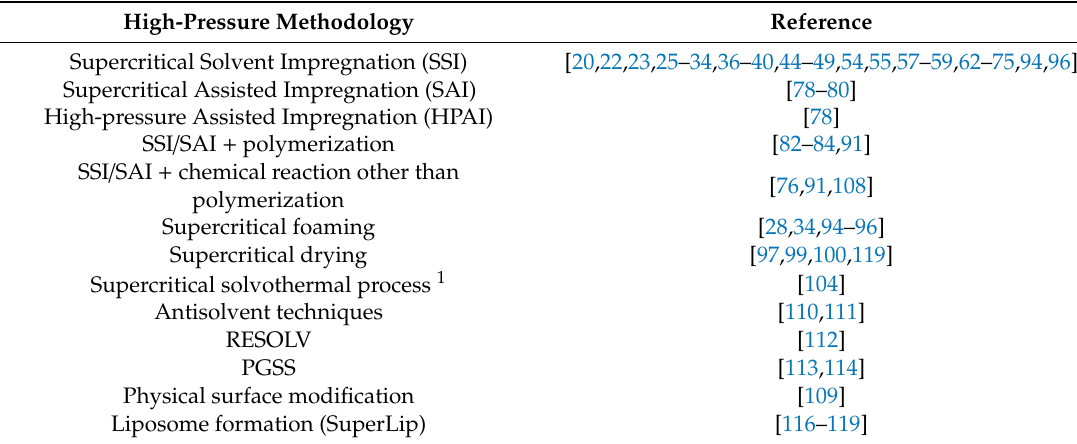
Table 2. Cited references related to the techniques